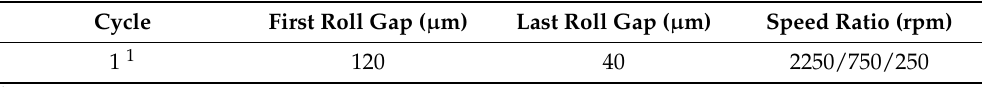
Table 1. Parameters of three-roll milling